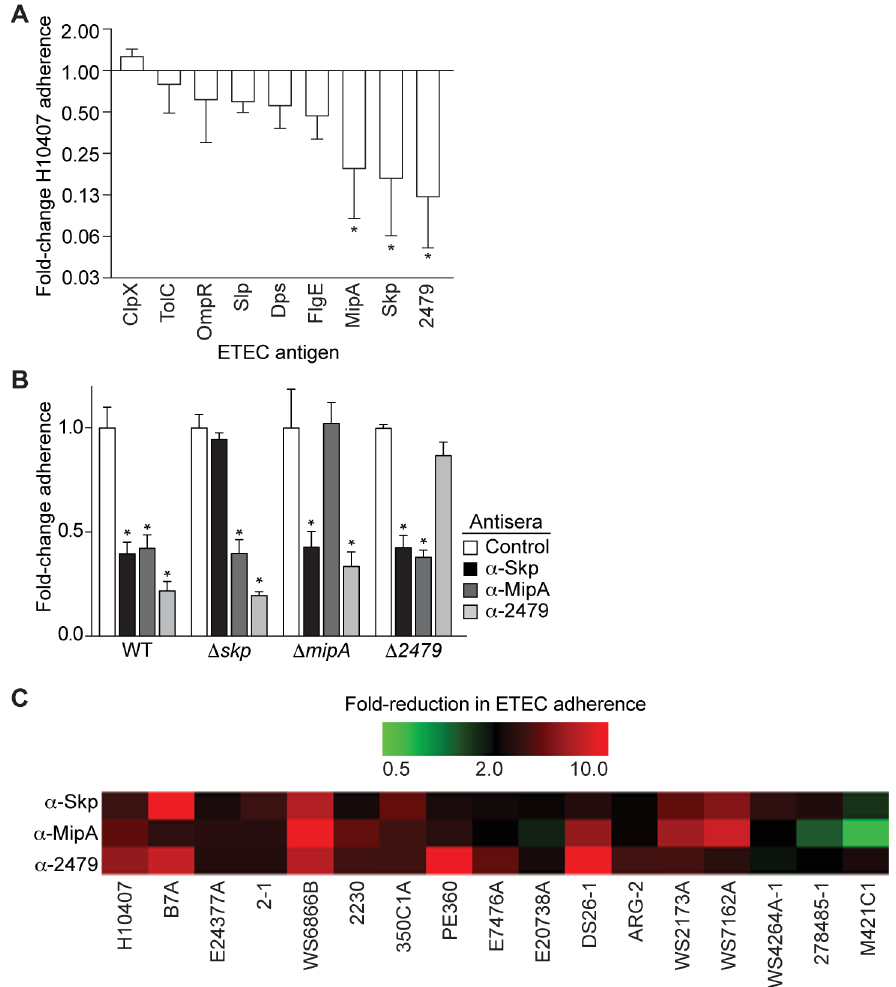
Fig 2. Adherence assays. A. Adherence of ETEC H10407 to HCT-8 cells in the presence of antisera. The fold-change in ETEC H10407 adherence is plotted as a function of incubation with the indicated antisera, after normalization to control samples. Asterisks indicate the antisera showing significant protection against ETEC H10407 that were selected for further characterization, n = 3/group. B. Analysis of antisera specificity. Deletion mutants were constructed for the skp , mipA , and ETEC_2479 genes and then analyzed for their adherence to HCT-8 cells in the presence of the indicated antisera. Asterisks indicate significant reduction in bacterial adherence, n = 4-12/group. C. Heat map displaying the fold-change in adherence of the indicated ETEC strains to HCT-8 cells after their incubation with the indicated antisera. The scale ranges from 0.5 to a 10-fold decrease in adherence, as compared with control samples, n = 3/group. Red colors depict reduced ETEC adherence in the presence of antisera, while green colors depict increased adherence. The midpoint of the color gradient was set as a 2-fold reduction in adherence